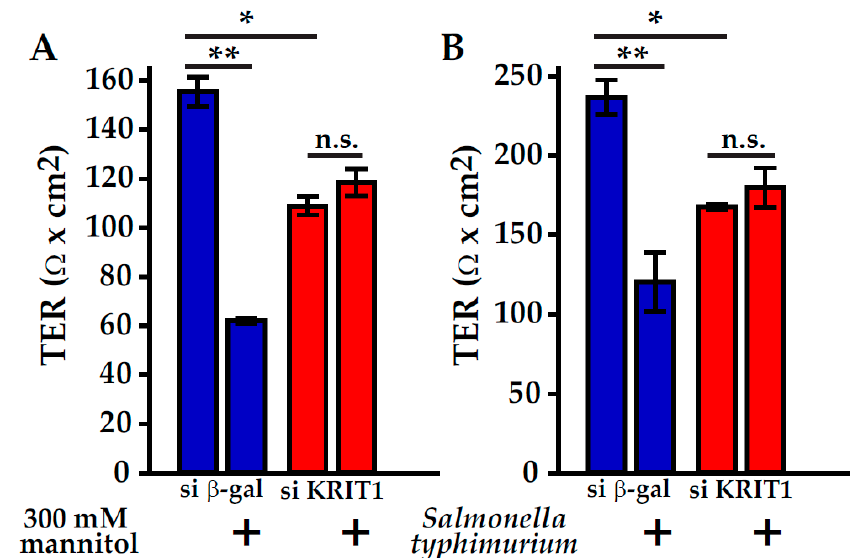
Figure 4. KRIT1 depletion limits pathophysiological stimuli-induced epithelial barrier